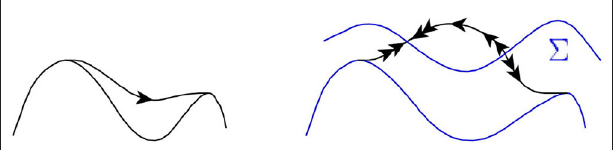
FIGURE 17 | Dynamics around a regular heteroclinic connection (left) and a folded heteroclinic connection (right) of Equation